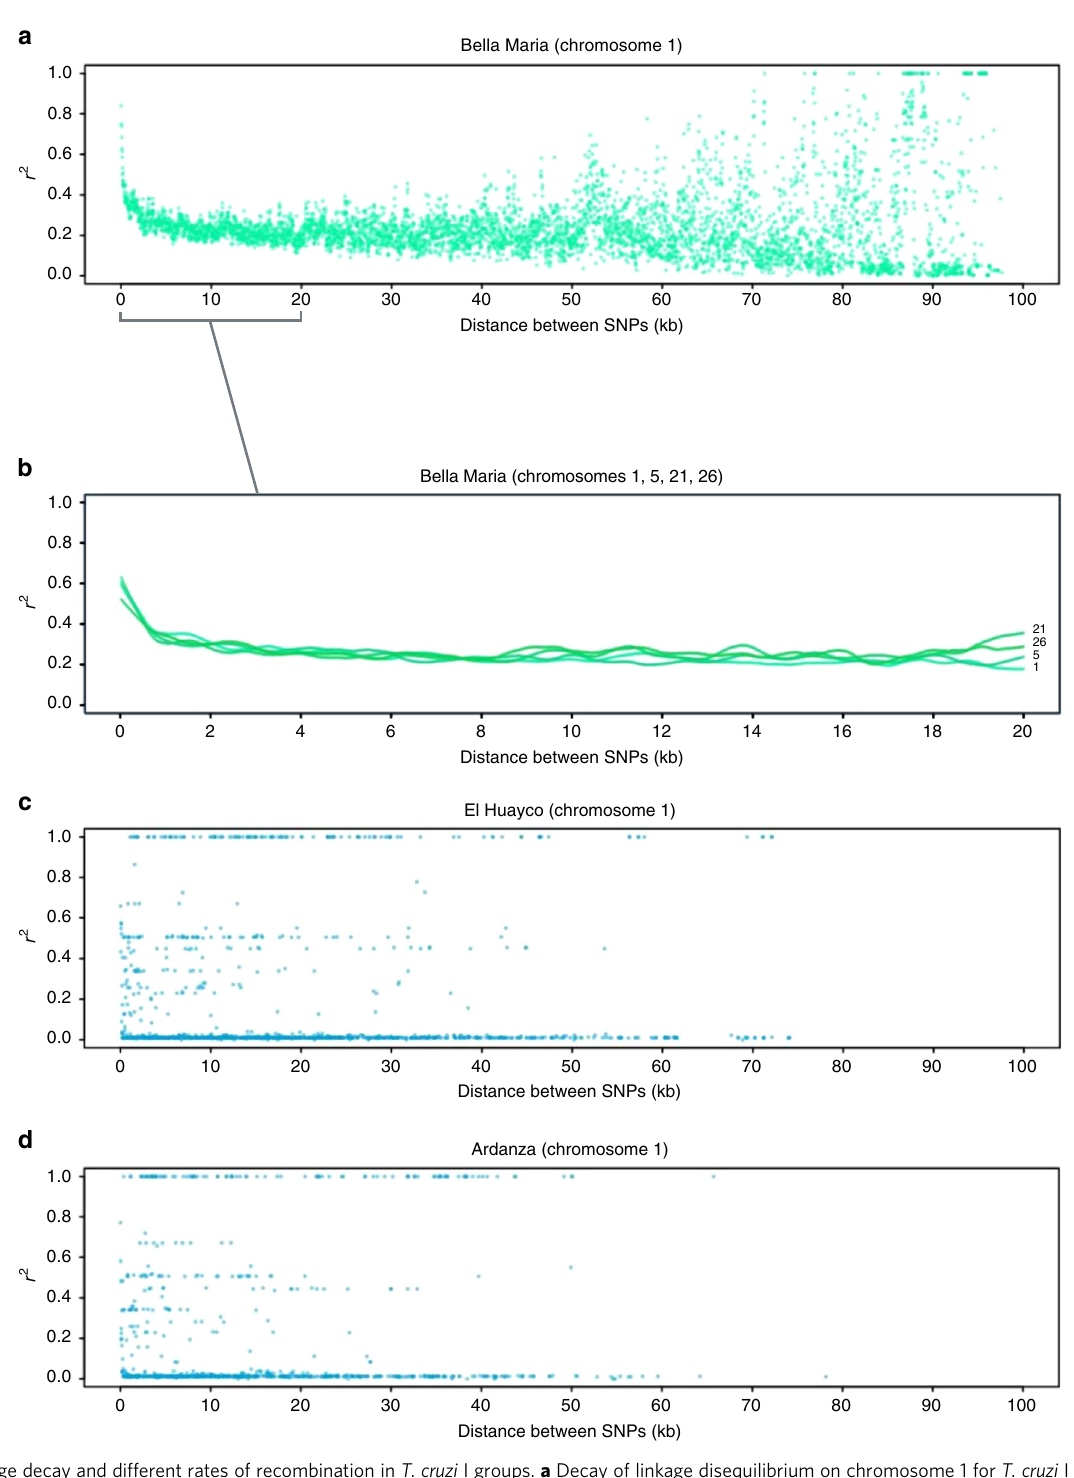
Fig. 3 Linkage decay and different rates of recombination in T. cruzi I groups. a Decay of linkage disequilibrium on chromosome 1 for T. cruzi I clones from Bella Maria. Average pairwise linkage values ( r 2 ) among SNP sites present in at least 90% individuals ( n = 5373) are plotted for map distance classes between 0 and 100 kb. b Local regression curves for the decay of linkage disequilibrium on chromosomes 1, 5, 21, and 26 for T. cruzi I clones from Bella Maria. c, d Lack of linkage decay on chromosome 1 for T. cruzi I clones from El Huayco (4093 SNPs) and Ardanza (3306 SNPs). Average pairwise linkage values ( r 2 ) are plotted against distance classes as for Bella Maria